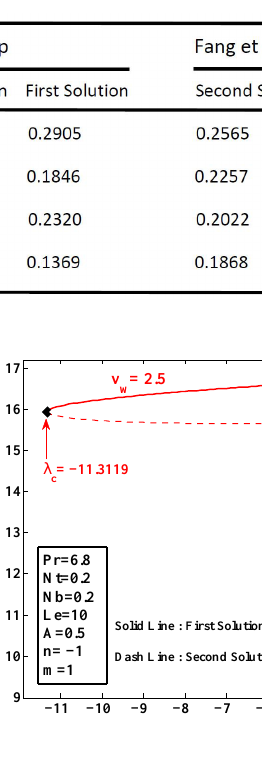
Figure 5: Variation of 1/ θ (0) with the shrinking parameter λ for